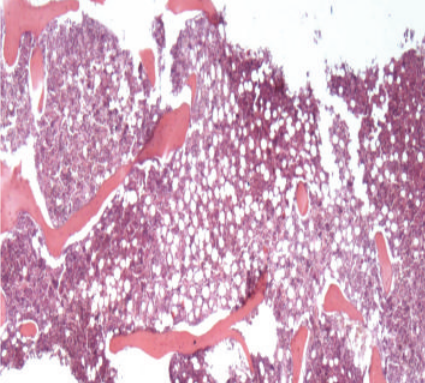
Figure 4: Bone marrow trephine biopsy with cellular marrow with leishmaniasis.